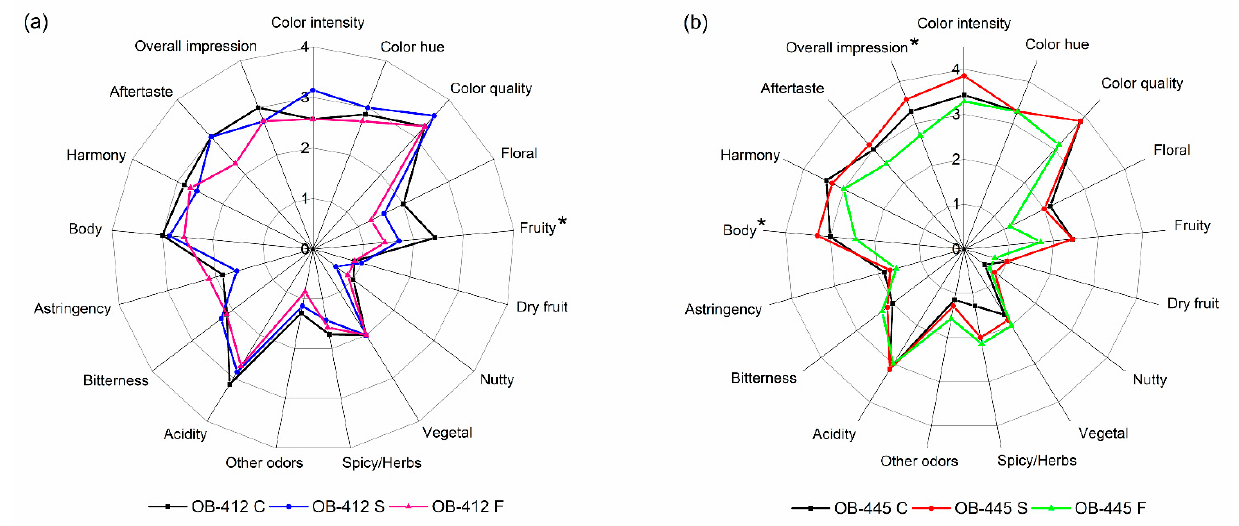
Figure 2. Quantitative descriptive analysis of produced wines: ( a ) clone OB-412; ( b ) clone OB-445. * Statistically significant differences between samples ( p < 0.05). Abbreviations: C- control variant, fermentation with S. cerevisiae Lalvin Sensy; S- fermentation with S. cereviasiae Sauvy yeast; and F- sequential fermentation of M. pulcherrima and S. cerevisiae .